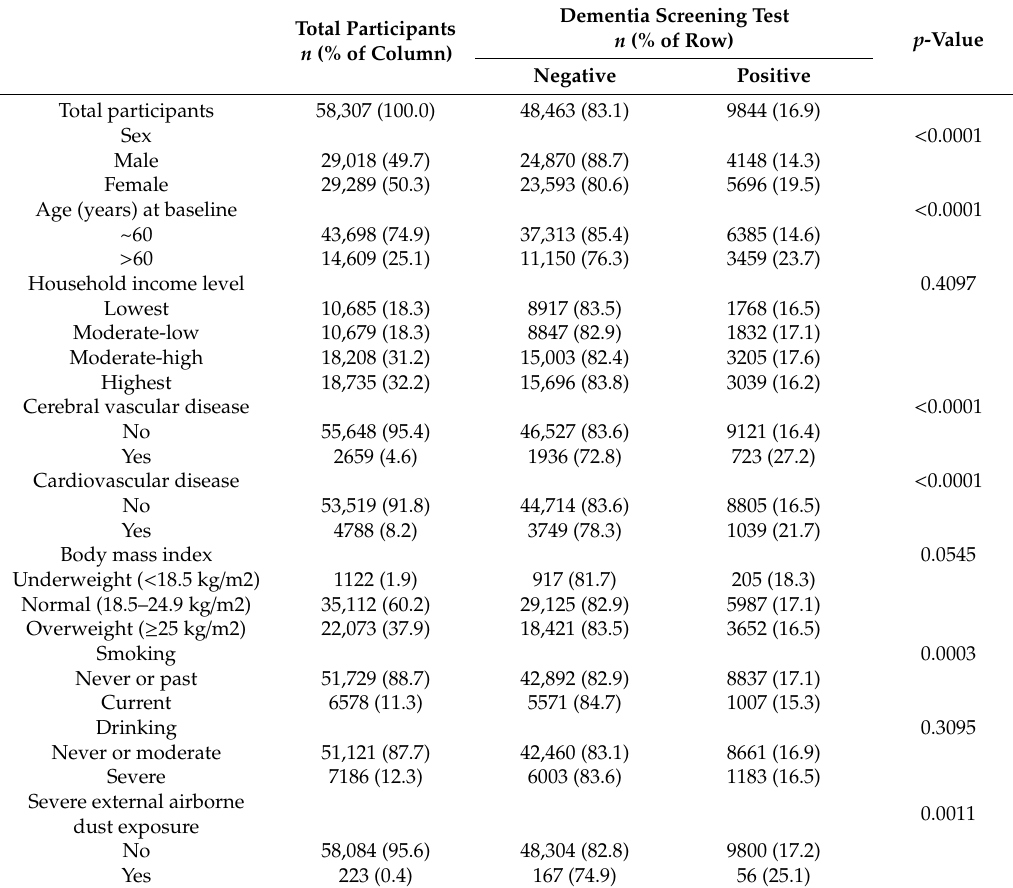
Table 3. Baseline characteristics of second National Screening Program for Transition Ages participants by dementia screening